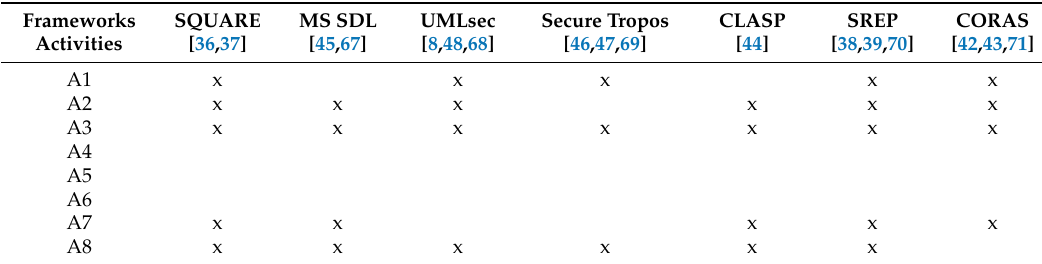
Table 4. Comparison of SRE